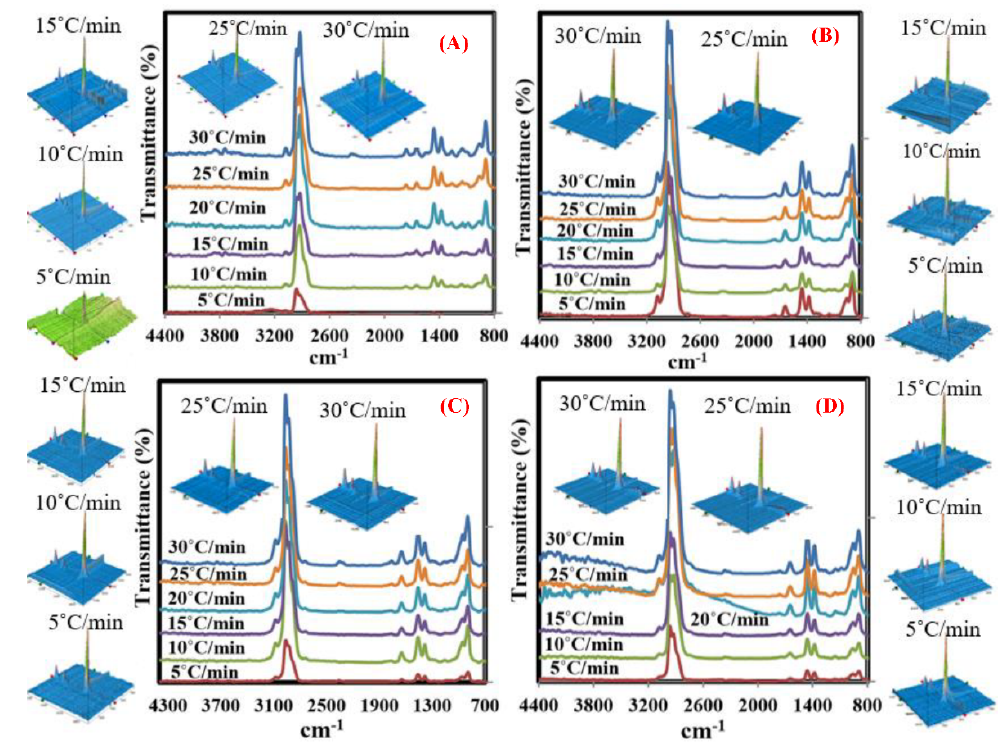
Figure 3. The 2–3D FTIR analysis of the decomposed ZSM-5/MFPW samples with concentration ( A – D ) 0, 10, 30, and 50 wt.%, at different heating rates (5–30 °C/min).